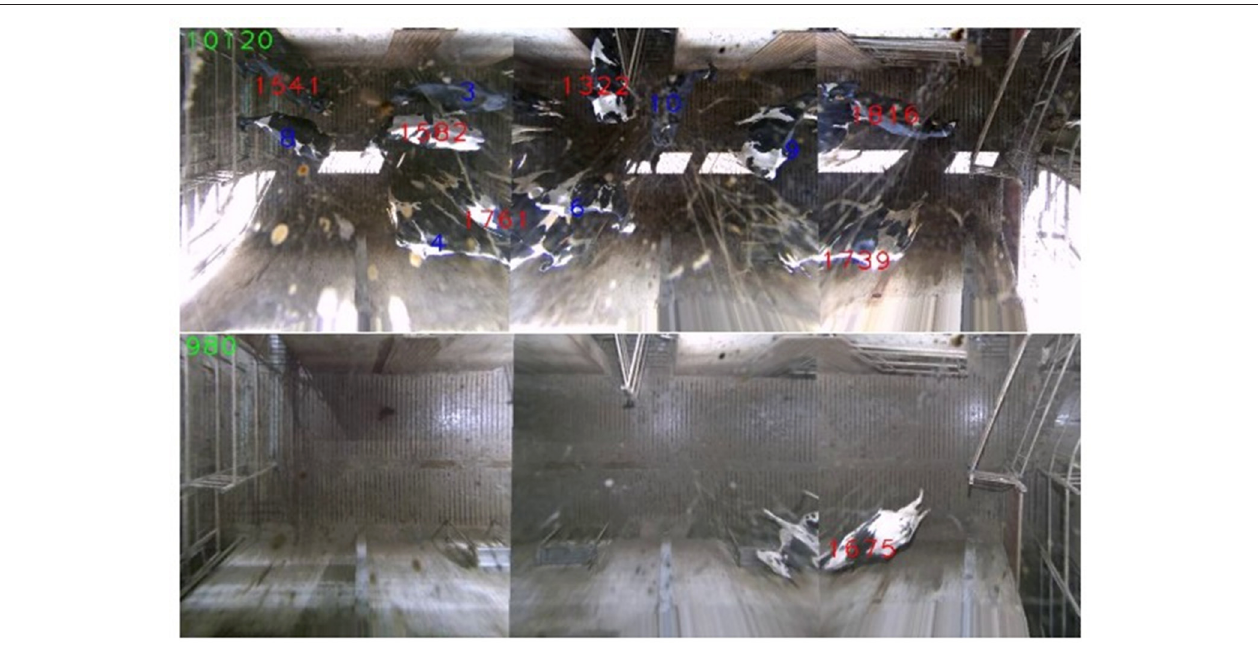
FIGURE 5 | Example frames, with tracked objects marked, from the crowded, sunny (top) and easy (bottom) sequence. The red ID-numbers are initiated and assigned by the selection gates and placed on the correct cow by the tracker, while the blue numbers are placed manually in the first frame and then further tracked.